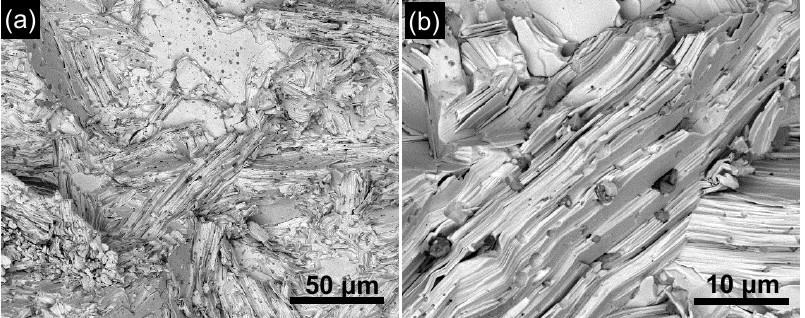
Figure 7. ( a , b ) SEM images of SPS-MW-A40 at different magnifications showing the dispersion of glass